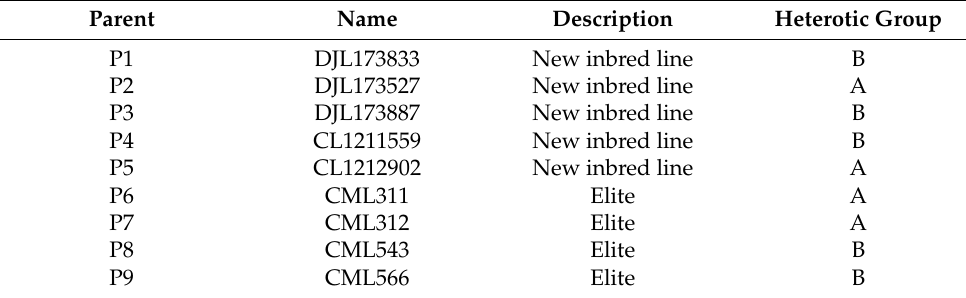
Table 1. Maize inbred line parents for the partial diallel crosses.